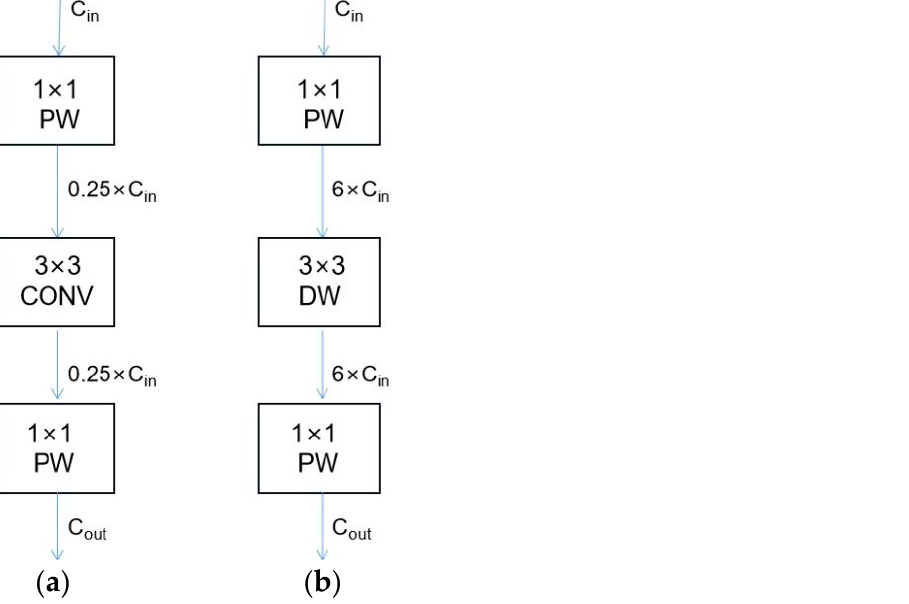
Figure 4. Comparison of MobileNet and ResNet structures: ( a ) ResNet; ( b ) MobileNetv2.